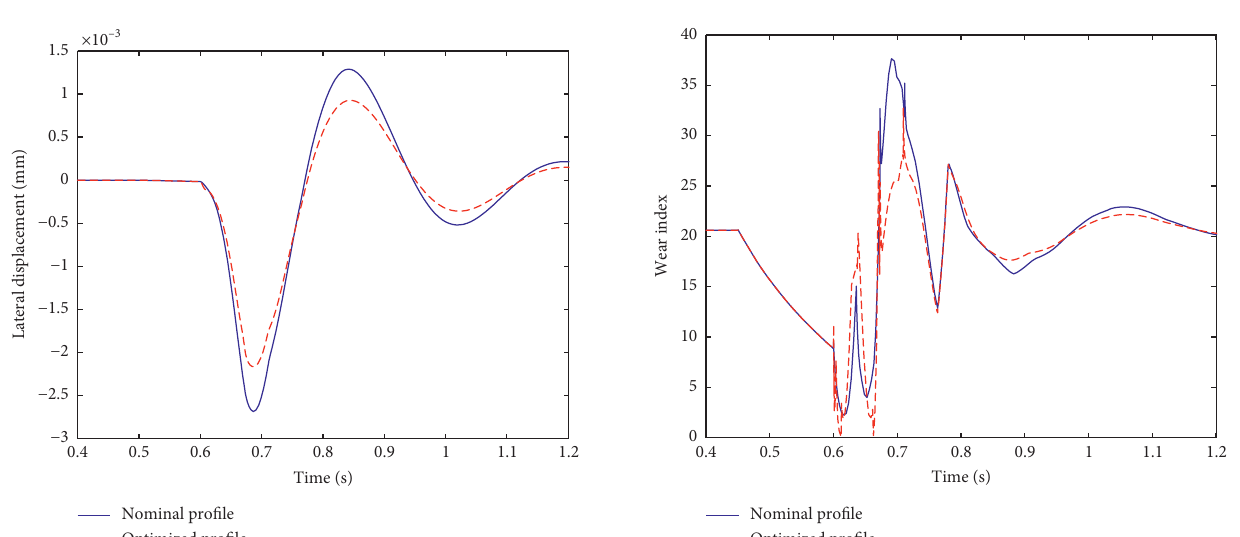
Figure 21: Lateral displacement of the first wheelset. Figure 22: Wear